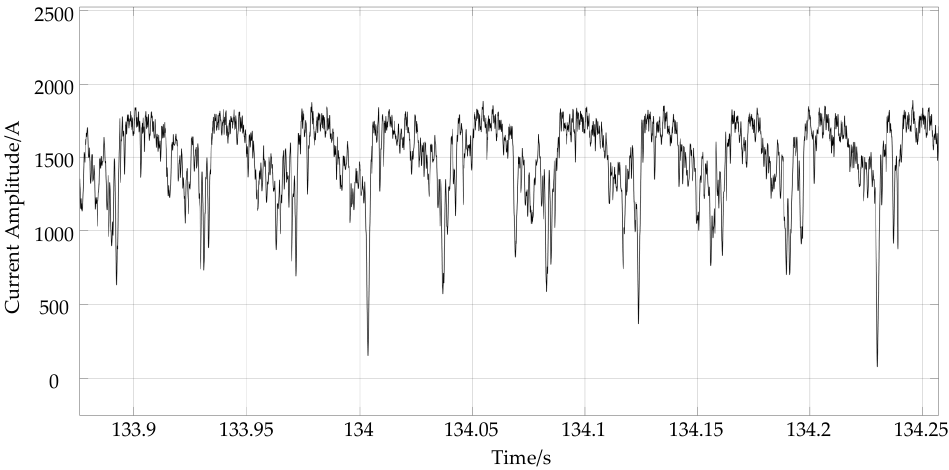
Figure 16. The q -axis current of the left stator winding after local zoom. The q -axis current variation of the stator segmentation switching process is shown in Figure 17. It shows that the two-step method has a large drop in current during the switching process, as there is a delay between the turn-on time of the next stator and the turn-off time of the current stator.